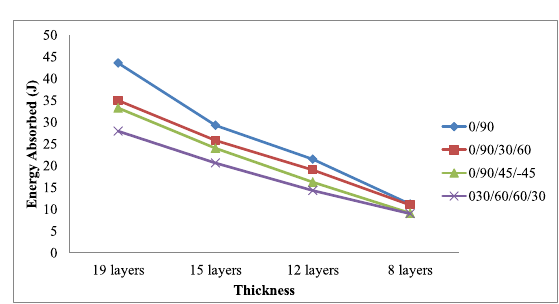
Figure 14. Experimentall determined variation of average energy absorbed by plates having a different thicknesses and lay-ups.